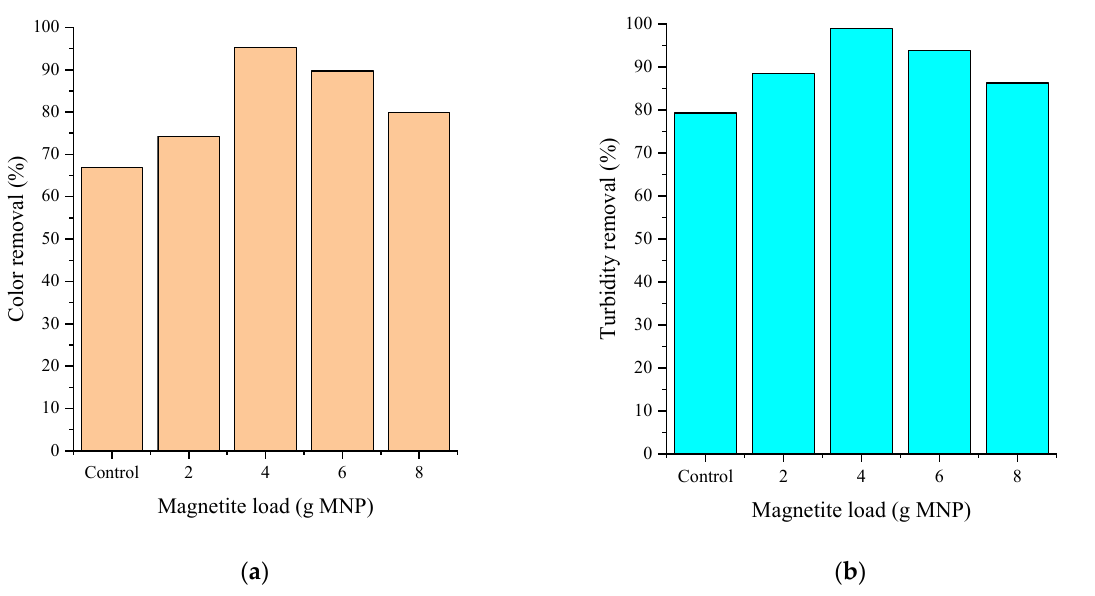
Figure 6. E ff ect of magnetite load on ( a ) color removal (%); ( b ) turbidity removal (%). Figure 6. Effect of magnetite load on ( a ) color removal (%); ( b ) turbidity removal